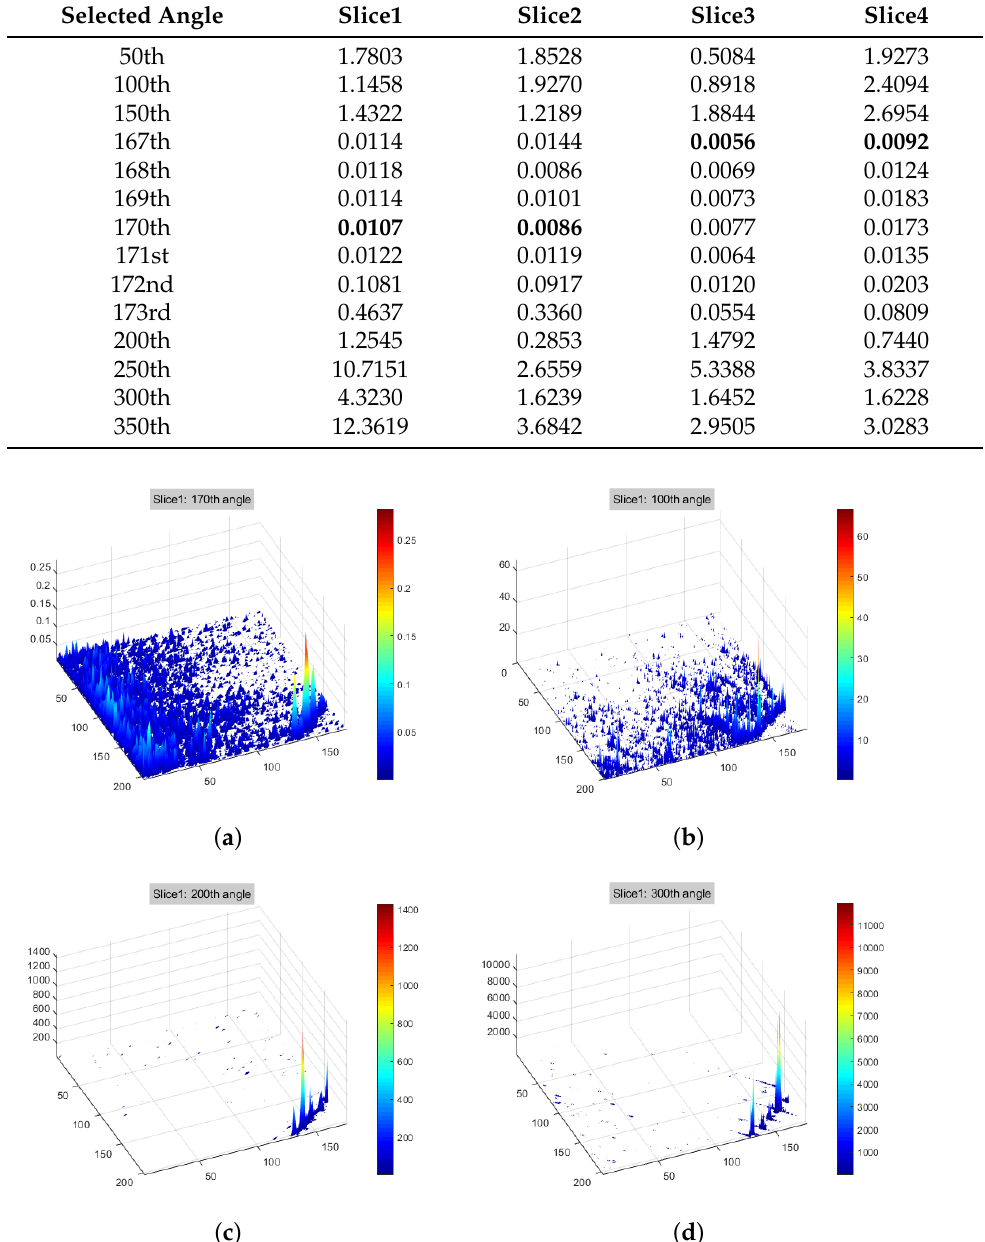
Figure 14. Target energy distribution for Slice1 (partial warehouse exists in slice): ( a ) 170th angle energy distribution: σ = 0.0107, maximum energy about 0.28; ( b ) 100th angle energy distribution: σ = 1.1458, maximum energy about 60; ( c ) 200th angle energy distribution: σ = 1.2545, maximum energy about 1400; ( d ) 300th angle energy distribution: σ = 4.3230, maximum energy about